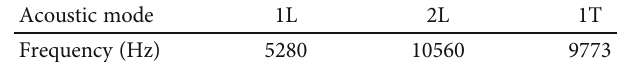
Table 1: The theoretical characteristic frequencies of the chamber. Acoustic